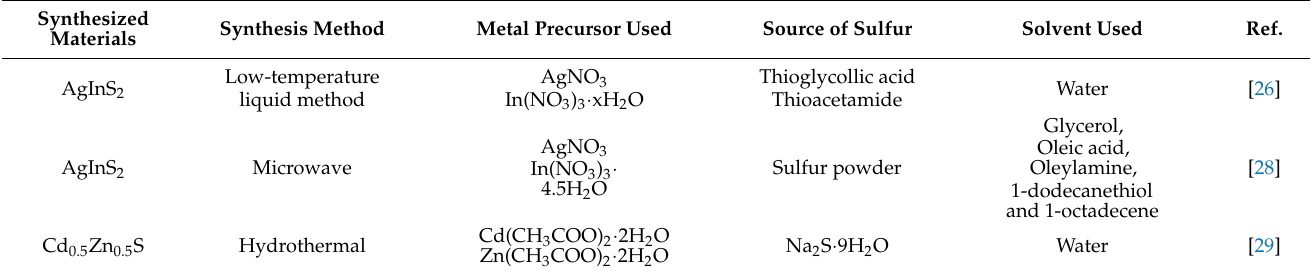
Table 1. Different preparation methods of